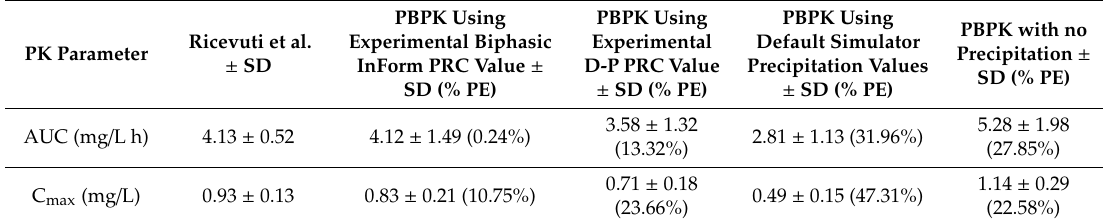
Table 4. Observed and modelled drug exposure pharmacokinetic parameters for 75 mg immediate release tablets of dipyridamole.